Question: Provide a publication-style caption for this figure.
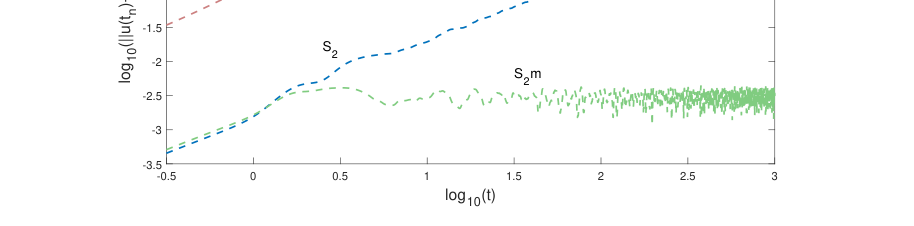
Answer: 3. Top: Trajectories of the six-body system modeling the outer Solar System. Bottom: relative error in energy as a function of time for an interval of 200000 days obtained with different splitting methods with (left) 1200 evaluations and (right) 2400 evaluations of the force.